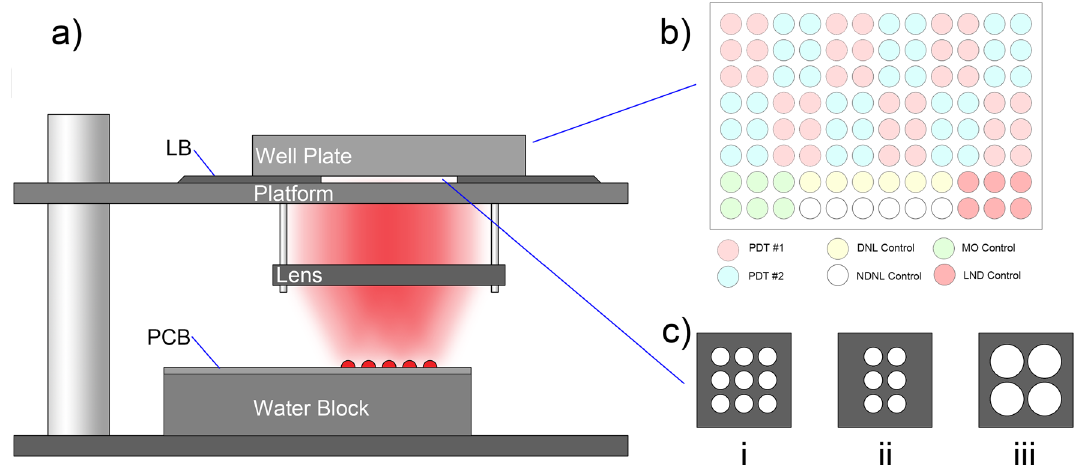
Figure 2. Optical setup for a 96-well plate. ( a ) A side view of the optical setup. LB, 3D-printed light blocker. ( b ) The well plate experimental group layout used for light dose response tests. PDT #1, PDT #2, two different treatment groups; DNL, drug with no light; NDNL, no drug with no light; MO, media only; LND, light with no drug. The staggered layout of PDT #1 and PDT #2 are suggested as a means to detect an incorrect alignment using the automated illumination system, which is an easy mistake in our experience when first setting up this system. Details regarding the staggered layout are described in the Supplementary Information (Well Plate Layout) . ( c ) The top view of the spatial light filter for (i) 9-well group for a 96-well plate, (ii) 6-well group for a 96 well plate, as depicted in ( b ), and (iii) 4-well group for a 24-well